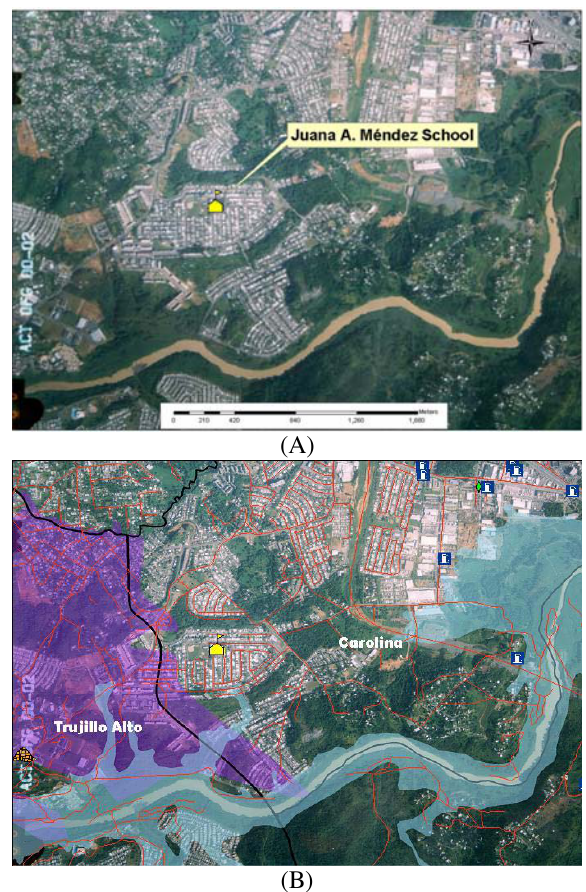
Figure 3: Aerial photos and maps illustrating the geographical and spatial relationship between the school setting and the location of anthropogenic and natural resources in the region in A. In B, the main industrial area is highlighted (in purple).